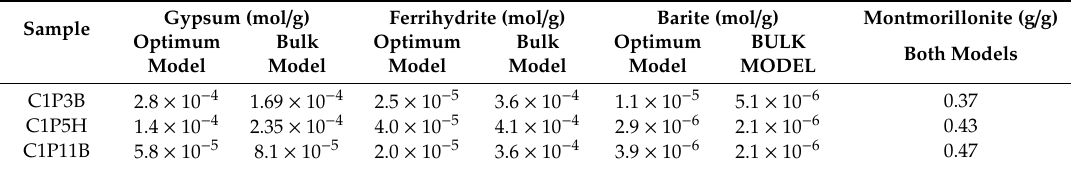
Table 3. Mineral quantities in the mineral assemblages implemented in the optimum model, and the model derived from the bulk